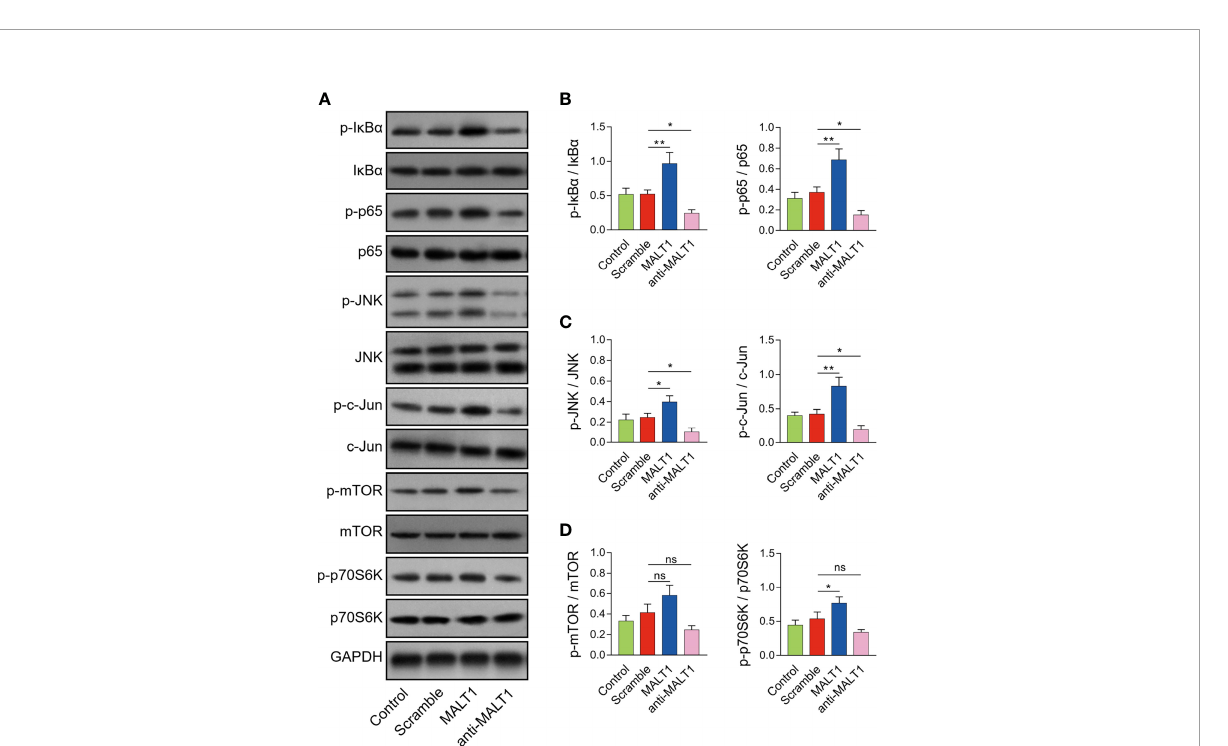
FIGURE 6 Effect of MALT1 on NF- k B, JNK, and mTOR pathways in RA CD4 + T cells. Examples of corresponding western blot images after lentivirus transfection (A) . p-I k B a and p-p65 (B) , p-JNK and p-c-Jun (C) , p-mTOR and p-p70S6K (D) protein expressions after lentivirus transfection. * meant P<0.05, ** meant P<0.01, ns meant not signi fi